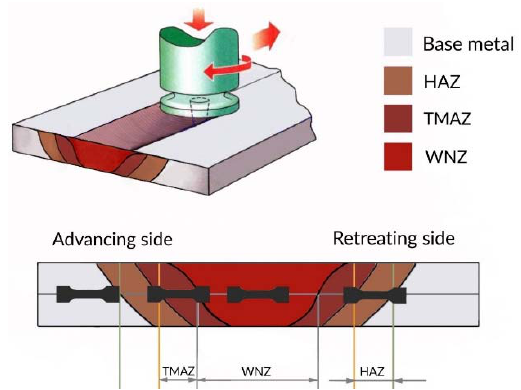
Figure 1. Schematic of the friction stir welding (FSW) process and cross section of the weld showing tensile specimens from different weld zone regions.